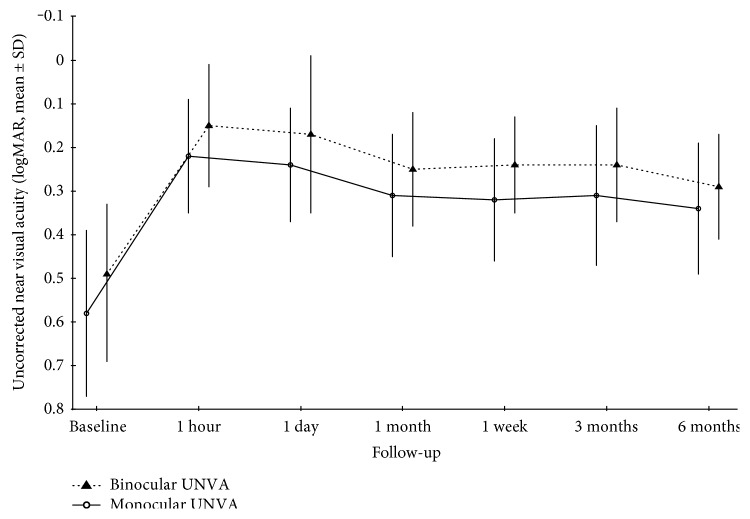
Monocular and binocular uncorrected near visual acuity changes during the follow-up.